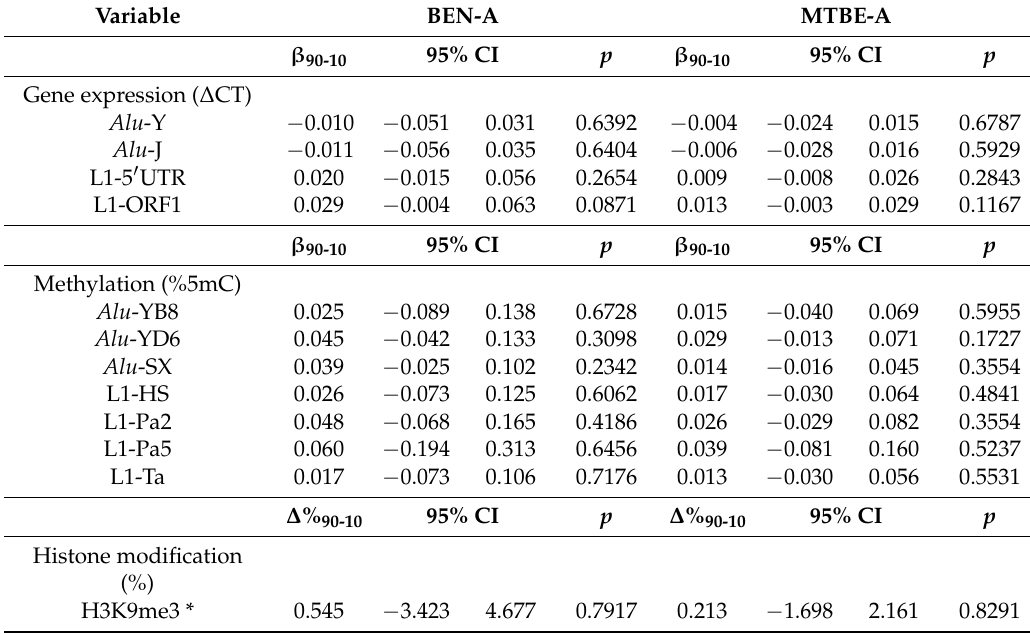
Table 3. Association between gene expression, DNA methylation, and histone modification in peripheral blood lymphocytes and personal exposure to airborne benzene and MTBE in all study subjects ( n = 179